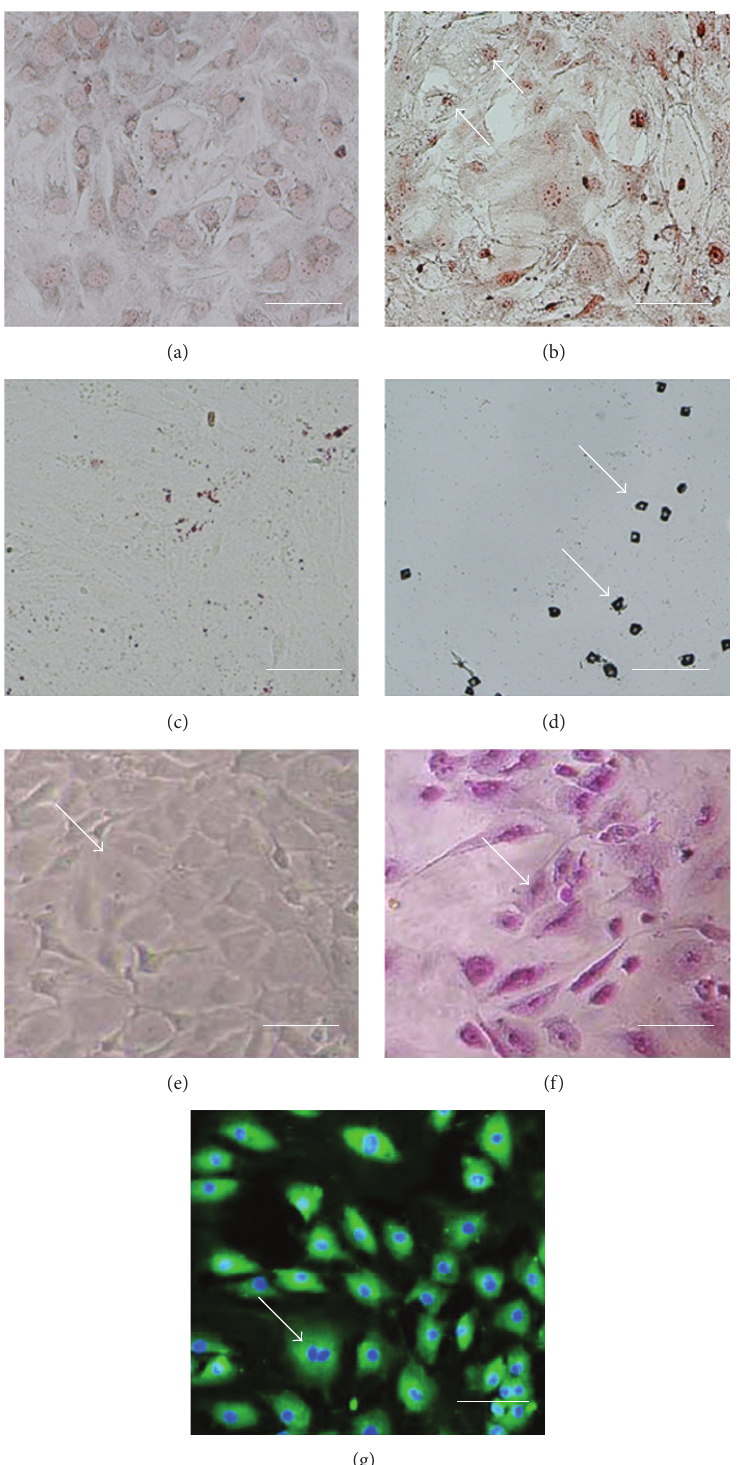
Figure 4: Differentiation potential of mouse liver-derived stem cells. (a, c) Uninduced LDSCs with their normal morphology stained negative for Oil Red O stain (a) and alizarin red (c). (b) Adipogenesis induced LDSCs were stained with Oil Red O stain showing positive for oil droplets after 4 weeks of induction. (d) Osteogenesis induced LDSCs were stained with alizarin red showing mineralized nodule after 4 weeks of induction. (e) Phase contrast image of hepatogenesis induced LDSCs showing typical polygonal shape from fibroblast shape. (f) Hepatogenesis was shown positive for PAS staining (glycogen storage). (g) Albumin expression in hepatocyte induced LdSCs showed by ICC. Scale bars represent 100 𝜇 m